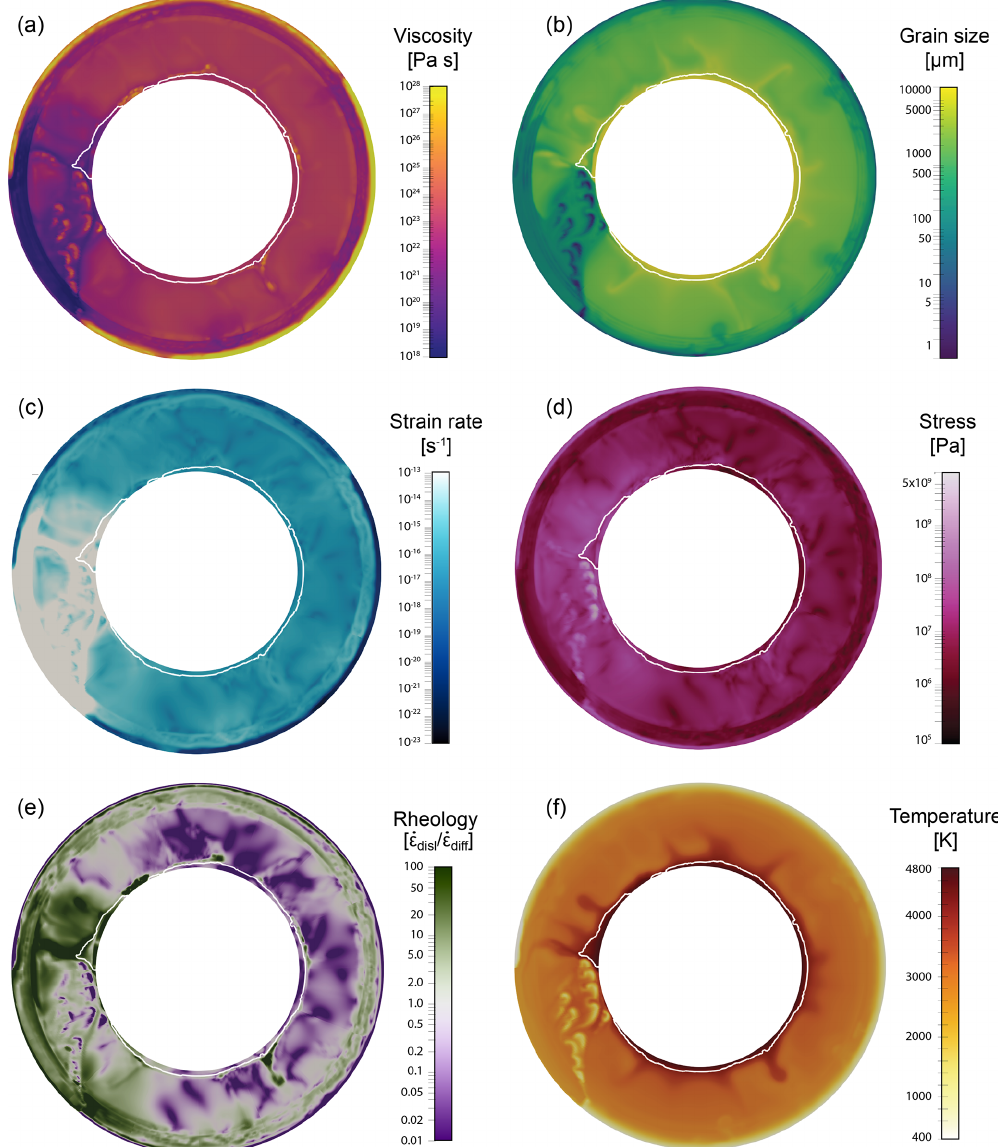
Figure 2. Snapshots of mantle dynamics at 1.5Gyr. The white line outlines the detected pile. A downwelling pushes the pile material around. The downgoing material is characterised by a high viscosity, very small grain size and low temperature. It mainly deforms in diffusion creep, as does most of the mantle. Only the upper mantle and parts of the pile accommodate more deformation in dislocation creep. The strain rate in the mantle surrounding the downwelling is very high, and viscosity surrounding the downwelling is very